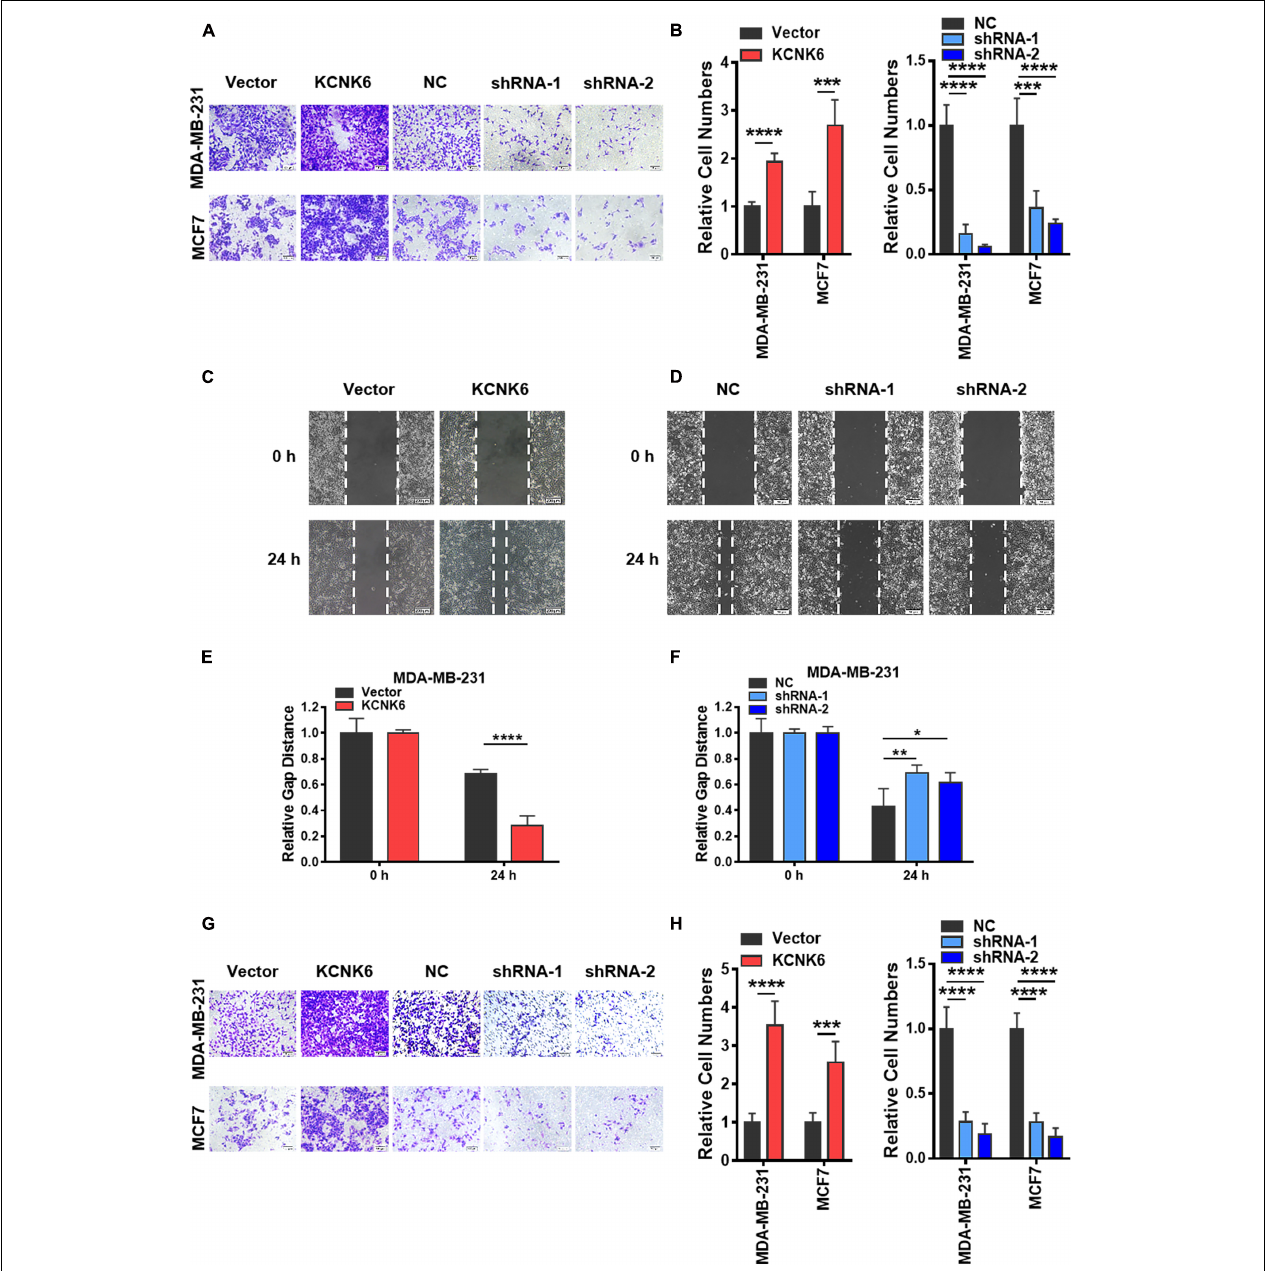
FIGURE 3 | KCNK6 expression affects the invasion and migration of breast cancer cells. (A) Transwell cell migration experiment results showed that the migration ability of MDA-MB-231 cells and MCF-7 cells was significantly enhanced after overexpression of KCNK6, and the migration ability of MDA-MB-231 cells and MCF-7 cells was significantly inhibited after knocking down KCNK6. (B) The number of migrating cells in each group was counted and plotted, showing that overexpression of KCNK6 could significantly promote the migration of MDA-MB-231 cells and MCF-7 cells, while knocking down KCNK6 significantly inhibited the migration of MDA-MB-231 cells and MCF-7 cells. (C) The scratch healing experiment showed that overexpression of KCNK6 could significantly promote the migration of MDA-MB-231 cells. (D) The software was used to measure the changes of scratch healing in each group at different time points, and the statistical chart was drawn. The results showed that overexpression of KCNK6 could significantly promote the migration of MDA-MB-231 cells. (E) In the scratch healing experiment showed that knocking down KCNK6 could significantly inhibit the migration of MDA-MB-231 cells. (F) The software was used to measure the changes of scratch healing in each group at different time points, and the statistical chart was drawn. The results showed that knocking down KCNK6 could significantly inhibit the migration of MDA-MB-231 cells. (G) Transwell cell invasion experiment showed that the invasive ability of MDA-MB-231 cells and MCF-7 cells was significantly enhanced after overexpression of KCNK6, and the invasive ability of MDA-MB-231 cells and MCF-7 cells was significantly inhibited after knocking down KCNK6. (H) The number of invasive cells in each group was counted and plotted showing that the invasive ability of MDA-MB-231 cells and MCF-7 cells was significantly enhanced after overexpressing KCNK6. After knocking down KCNK6, the invasive ability of MDA-MB-231 cells and MCF-7 cells was significantly inhibited. * P < 0.05; ** P < 0.01; *** P < 0.001; **** P < 0.0001.